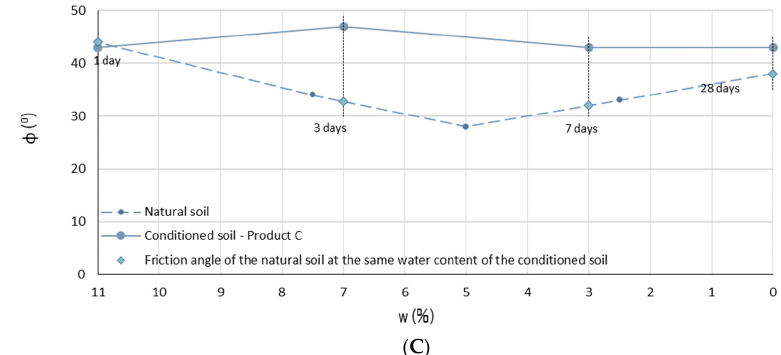
Figure 6. Results of direct shear test for products A, B and C. ( A ) Results of direct shear test for products A—Friction angle; ( B ) Results of direct shear test for products B—Friction angle; ( C ) Results of direct shear test for products C—Friction angle.